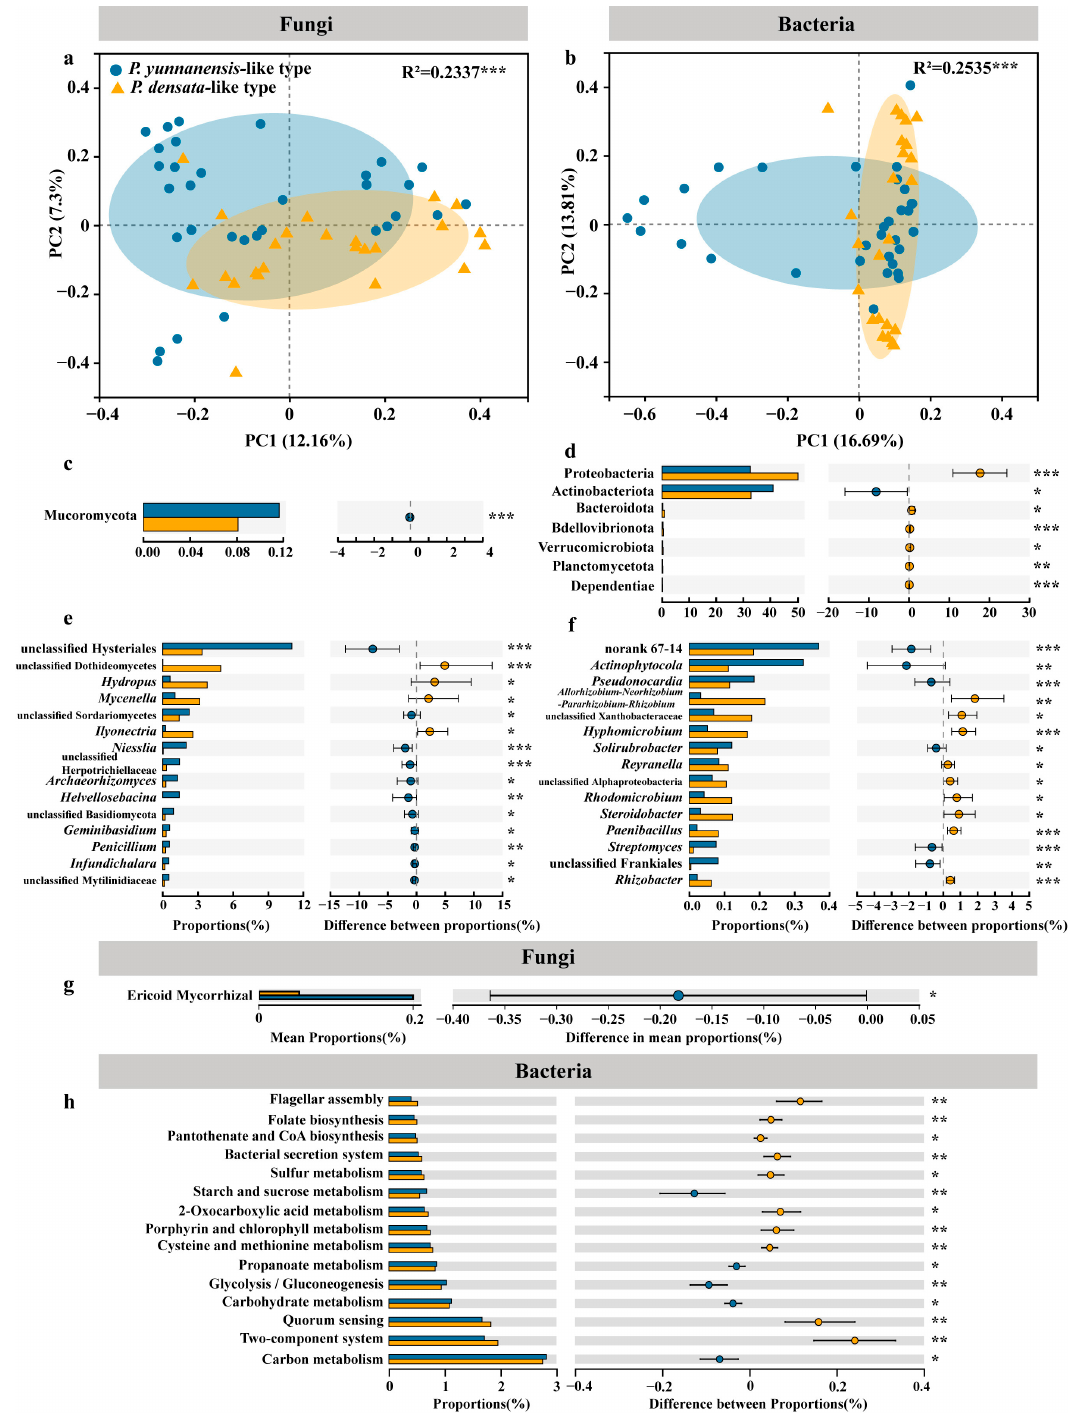
Figure 5. Differentiation of endophytic microbial communities and predicted KEGG or MetaCyc functions predicted by PICRUSt2 between the Pinus yunnanensis -like type and Pinus densata -like type. The PCoA of the root endophytic fungal ( a ) and bacterial ( b ) communities of different pine types. The different groups between the P. yunnanensis -like type and P. densata -like type at the phylum ( c , d ) and genus ( e , f ) levels. The different functions between rhizosphere soil and roots predicted by FUNGuild ( g ) and PICRUSt2 ( h ). Mann–Whitney U tests were used to evaluate differences in the abundance of pine root endophytes. Significant difference: * p ≤ 0.05, ** p ≤ 0.01, *** p ≤ 0.001. “U-” represents “unclassified-”.